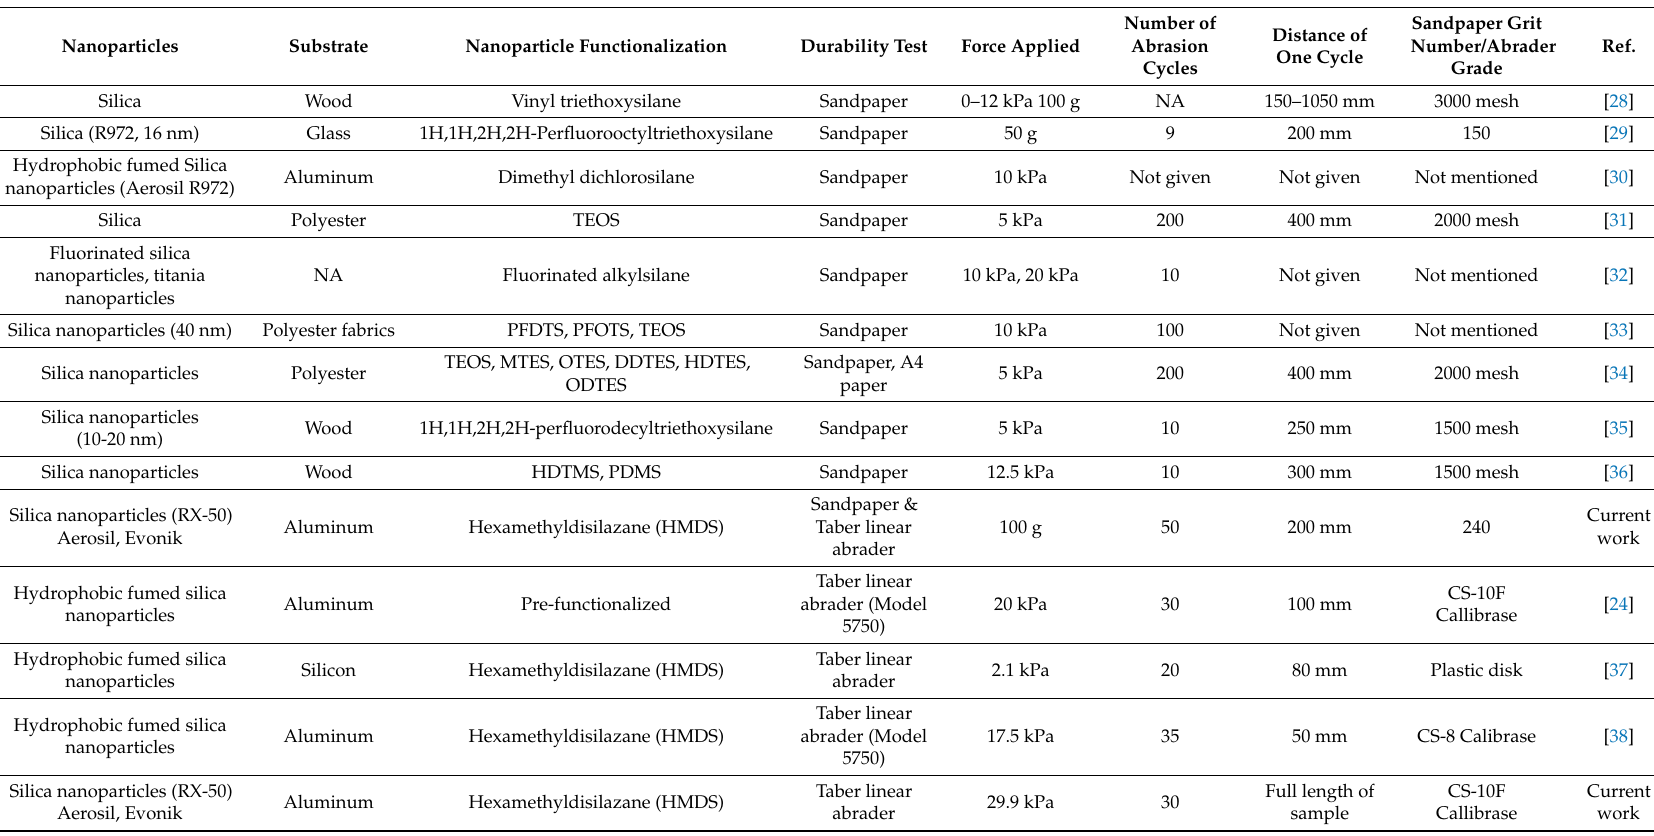
Table 3. Summary of published works on the mechanical durability of silica nanoparticle based superhydrophobic coatings using Sandpaper abrasion tests and Taber linear abrasion tests. The current study included at the end of the table for the purpose of